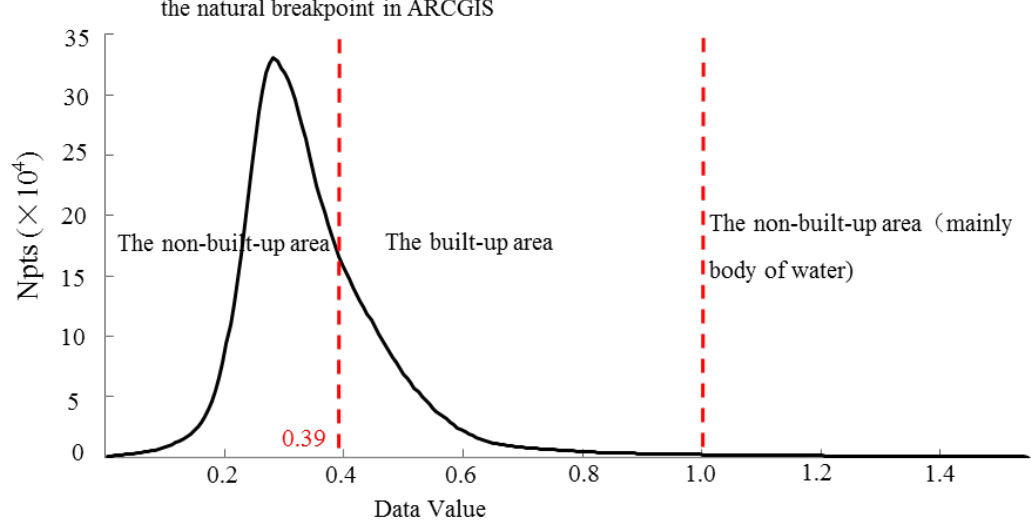
Figure 5. The histogram of NDSTI and the threshold interval of the built-up area in the Tangshan study area.